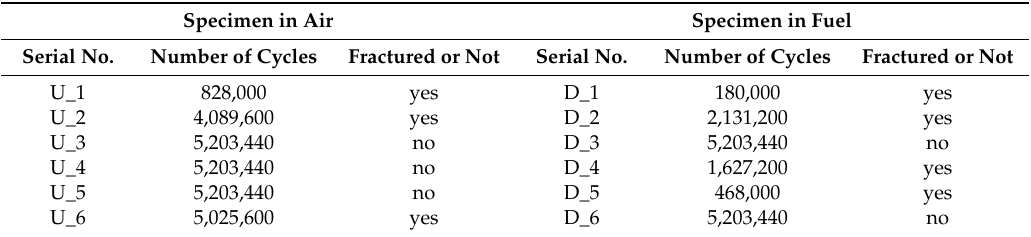
Table 6. Test results at an acceleration of 8.55 g.